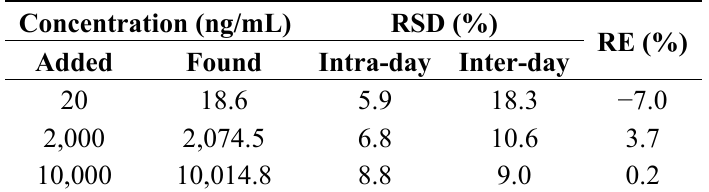
Table 2. Accuracy and precision for the analysis of azacitidine in rat plasma (three validation days, six replicates at each concentration level per day).